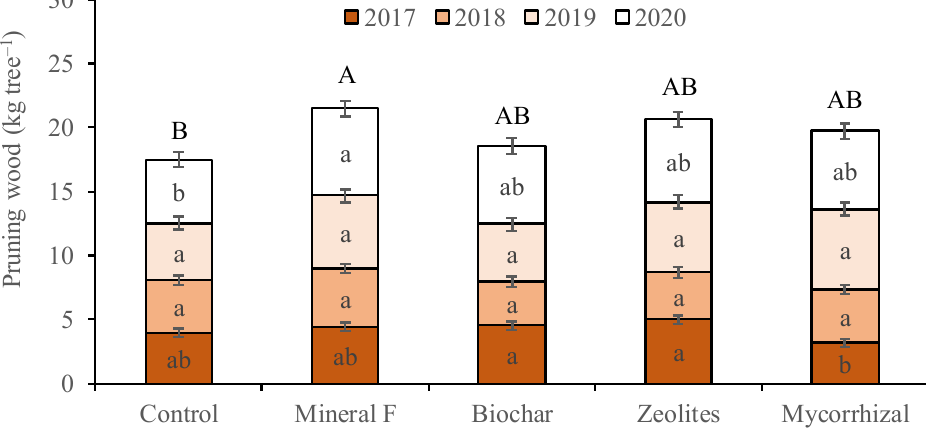
Figure 3. Annual pruning wood and accumulated total. Separated by year (lowercase letters) and total (uppercase letters), means followed by the same letter were not significantly different by Tukey HSD test ( α = 0.05). Vertical bars are the standard errors.